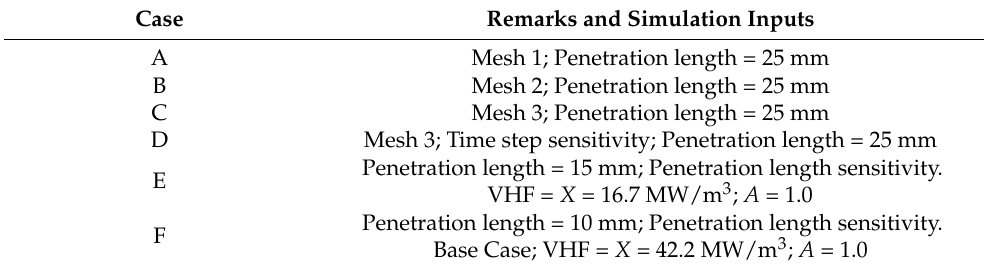
Table 1. Simulation matrix employed in the current